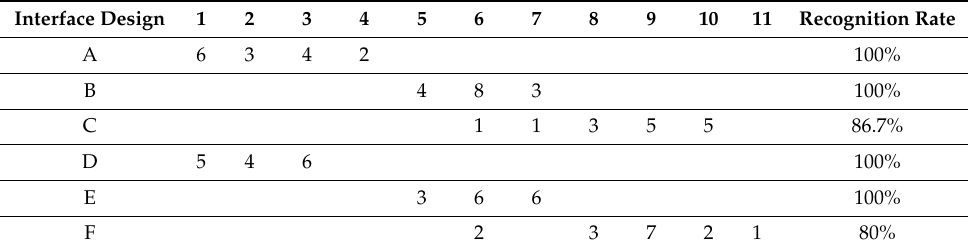
Table 1. Emotion recognition test results for the 6 interface designs.